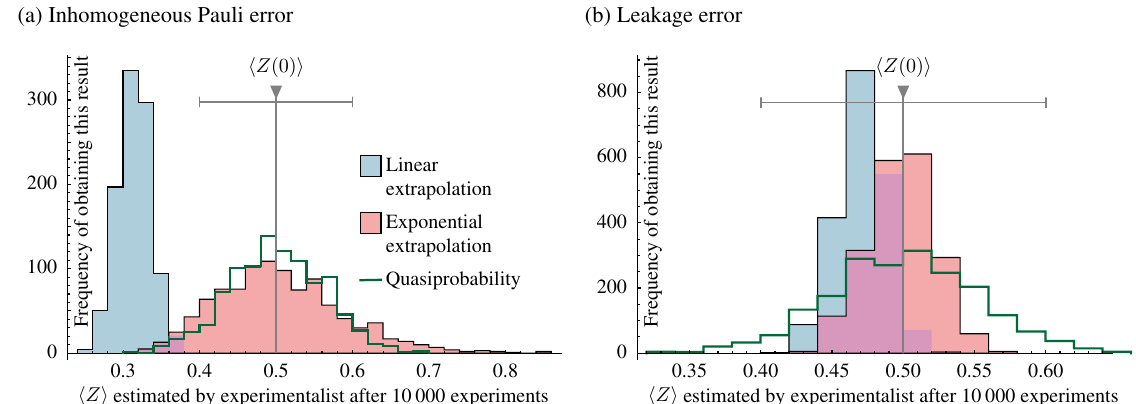
estimated by experimentalist after 10 000 experiments (cid:3) Z (cid:2) FIG. 6. Comparison of optimized quantum error mitigation techniques. The green outlines correspond to the quasiprobability technique while solid histograms correspond to the extrapolation technique using a presumption of an underlying linear (blue) or exponential (red) dependence. For the inhomogeneous Pauli error model, the SWAP -test circuit involving 19 qubits is simulated. For the leakage error model, the SWAP -test circuit involving fewer qubits (15 qubits) is simulated. The horizontal axis is the estimate of h Z i that an experimentalist who performs 10 4 experiments will obtain. Ideally the circuit produces h Z i ¼ 0 . 5 . Panel (a) corresponds to physical errors of the inhomogeneous Pauli type, while panel (b) corresponds to physical leakage errors. Note that the horizontal scale differs between the two panels; a gray bar showing the scale from 0.4 to 0.6 appears in both panels to facilitate comparison. For either type of noise, it is clear that exponential extrapolation mitigates noise more than linear extrapolation.